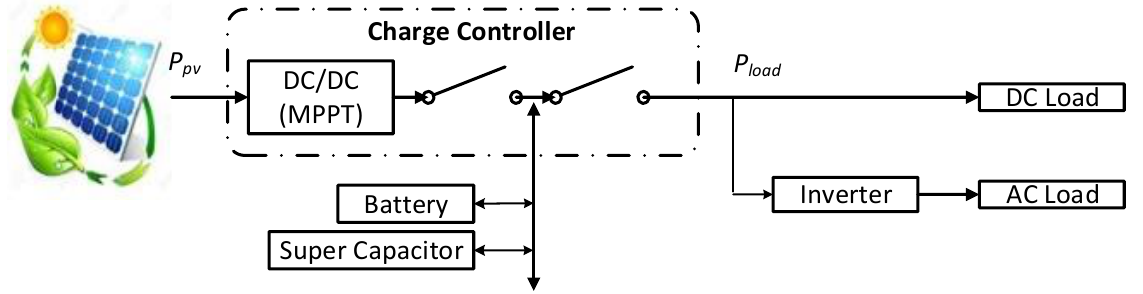
Figure 7. Passive HESS based autonomous PV grid.